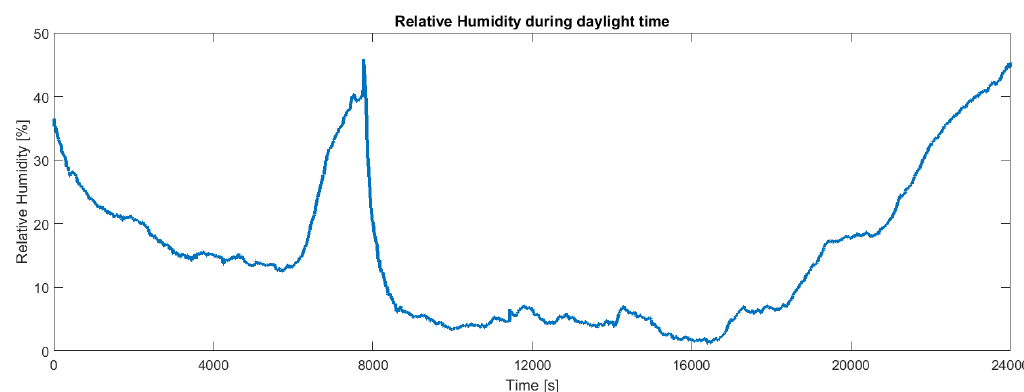
Figure 10. Behavior of the relative humidity corresponding to the temperature in Figure 9.